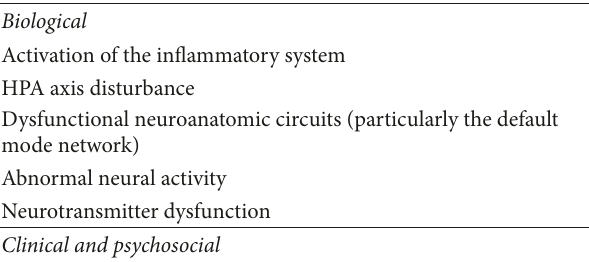
Table 2: Summary of the biological, psychological, genetic, and clinical correlates of